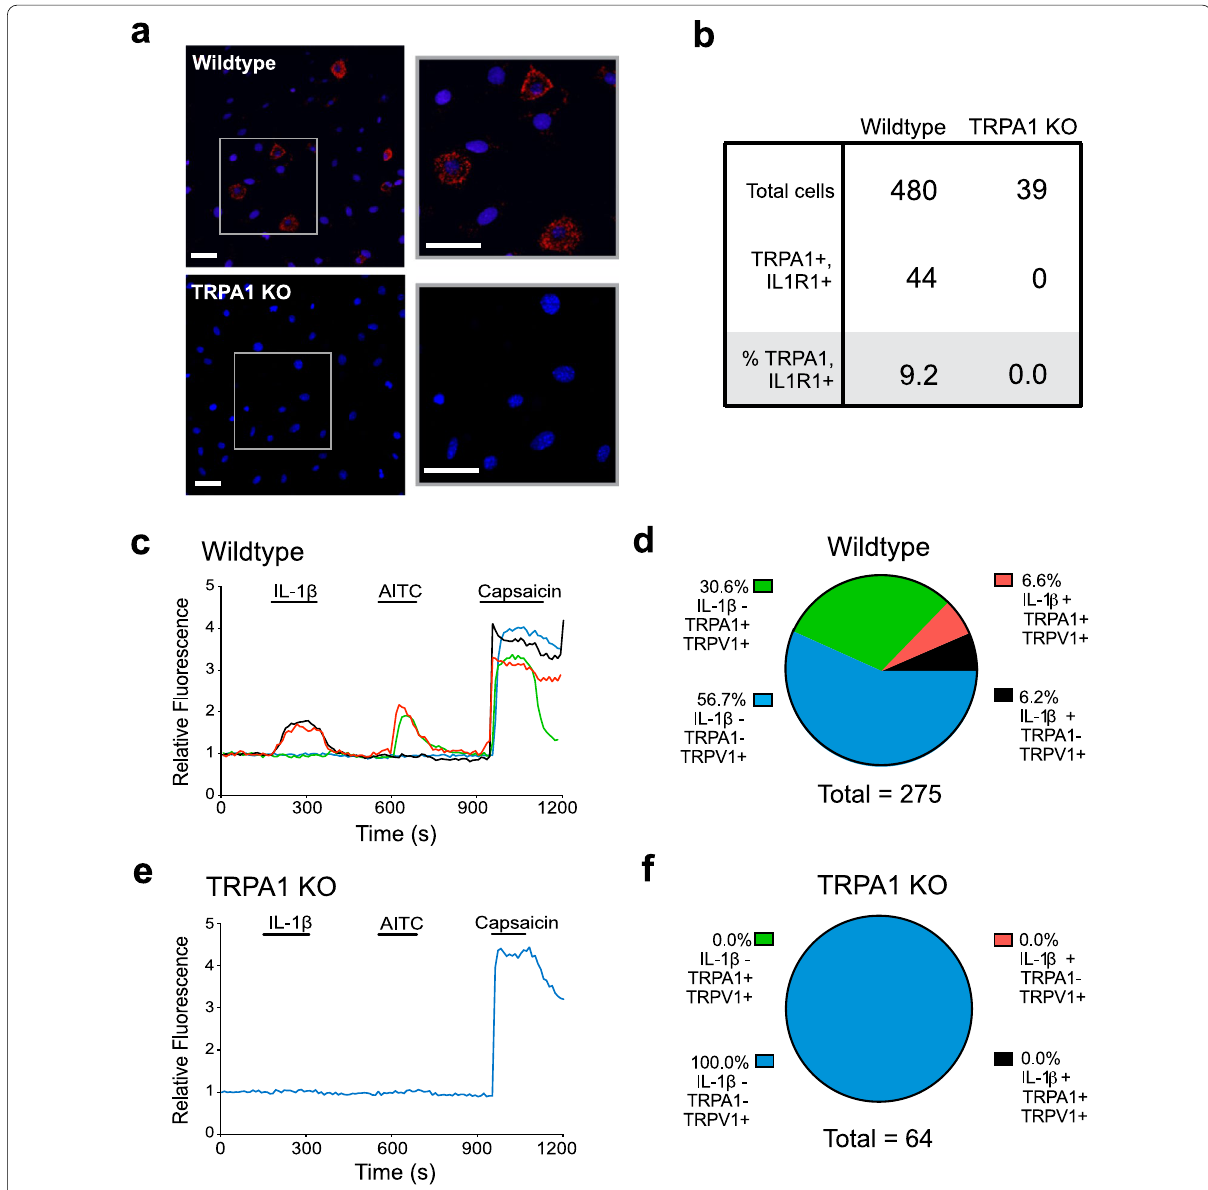
Fig. 2 TRPA1 and IL1R1 co-localize on nodose ganglia sensory neurons, and TRPA1 is required for IL-1β mediated calcium signaling. a Representative in situ image of proximity ligation assay showing close proximity of TRPA1 and IL1R1 on nodose ganglion neurons (Scale bar 50 µm). Nodose sensory neurons were isolated from wildtype and TRPA1 KO mice and subjected to in situ proximity ligation assay = (“Methods”), using primary antibody pairs of anti-TRPA1 and anti-IL1R1 antibodies. The cells were counterstained with DAPI (blue) to visualize the nucleus. b Quantification of nodose ganglion neurons showing TRPA1 and IL1R1 co-localization. c – f IL-1β-induces sensory neuron activation in a TRPA1-dependent manner. Nodose ganglion sensory neurons harvested from c wildtype (B6.129PF) or e TRPA1 KO mice were stimulated in culture with IL-1β (20 µg/mL), AITC (100 µM; TRPA1-agonist) and capsaicin (10 µM; TRPV1-agonist) indicated by the labeled black line segments. c , d Sensory neurons from wildtype (B6.129PF) mice respond to IL-1β. c Representative examples of calcium traces of wildtype (B6.129PF) sensory neurons responding to IL-1β, AITC, and capsaicin (blue line); to IL-1β and capsaicin (red line); to AITC and capsaicin (green line) and only capsaicin (black line) are shown. d Percentage breakdown of wildtype calcium responses. Neurons responding to IL-1β, AITC, and capsaicin (blue); to IL-1β and capsaicin (red); AITC and capsaicin (green); and only capsaicin (yellow), are shown. These data were obtained from 17 coverslips cultured using nodose neurons harvested from 16 to 20 mice. e , f Sensory neurons from TRPA1 KO mice fail to respond to IL-1β. e Representative calcium traces of sensory neurons isolated from TRPA1 KO in response to IL-1β, AITC and capsaicin. f Percentage breakdown of TRPA1 KO calcium responses. Neurons responding to IL-1β, AITC, and capsaicin (blue); to IL-1β and capsaicin (red); AITC and capsaicin (green); and only capsaicin